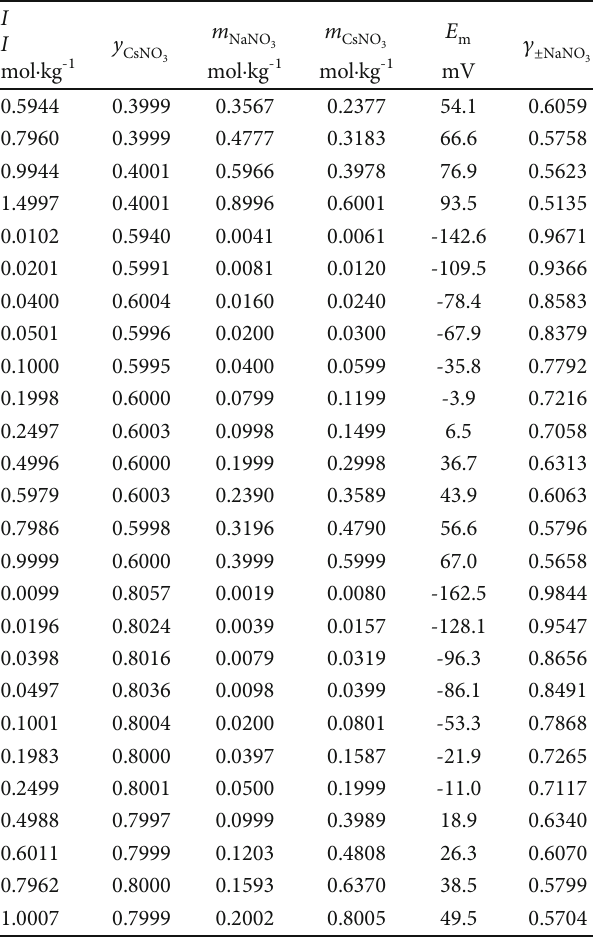
Table 4: Measurement results of the mean activity coe ffi cients of NaNO in the ternary system at 298.15K a . 3